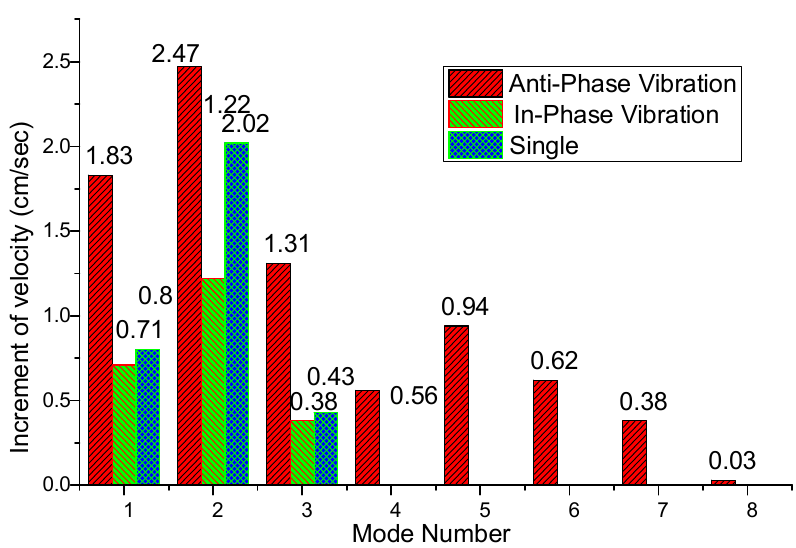
Figure 18. The increment of velocity for the pumping element in anti-phase vibration, in-phase vibration, and single plate.